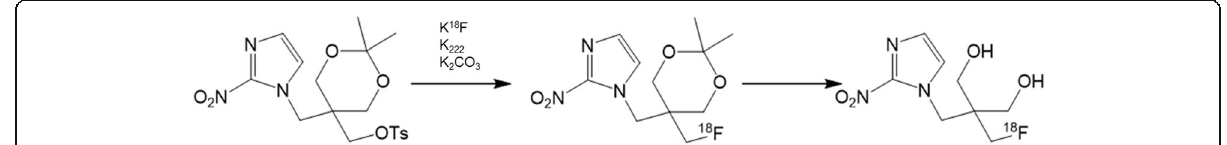
Fig. 1 Synthesis of [ 18 F]DiFA from its